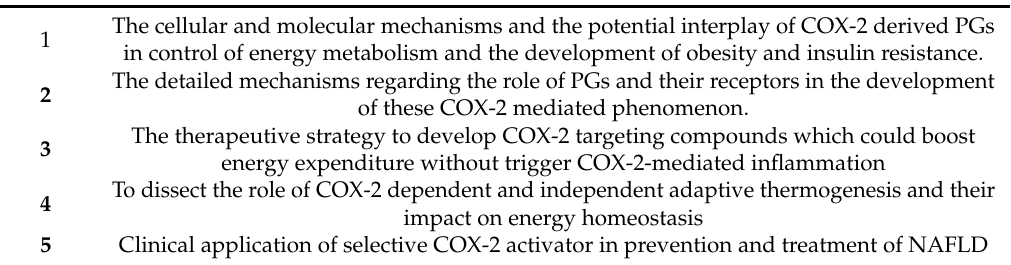
Table 3. Opportunities for future